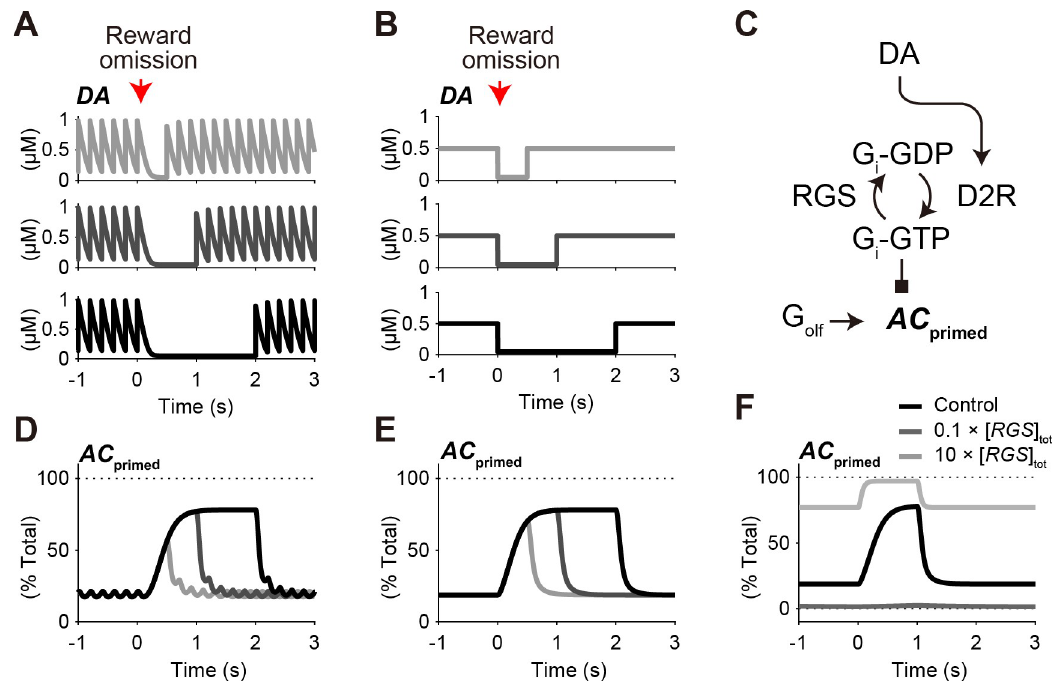
Fig 2. Characterization of optogenetically-evoked DA dynamics as a square wave dip. (A) Simulation of optogenetically-evoked DA dynamics (5 Hz) and their pauses for 0.5 s, 1.0 s, and 2.0 s (top, middle, and bottom, respectively). The tonic optogenetic stimulation is set to generate 0.5 μ M DA on average, and the DA pause is set to give 0.05 μ M DA at bottom levels (see Methods). (B) Characterization of the optogenetic DA signals as square wave dips. (C) Introduction of AC primed as the G i -free and G olf -bound state of AC. Further Ca 2+ stimulation leads to the activity of AC1. In the case of AC5, AC primed corresponds to a normalized activity of AC. (D) Dynamics of AC primed in response to the optogenetically-evoked DA signals. (E) Dynamics of AC primed in response to the square-wave DA dips. (F) Appropriate range of [ RGS ] tot is required for the response of AC primed . Square-wave DA dips are given with a duration of 1 s. AC primed reaches almost the maximal level even with the basal DA signal if [ RGS ] tot is set to be 10 times higher than the standard concentration (9 μ M, light gray line), and AC primed does not show any increase if [ RGS ] tot is 10 times lower than the standard concentration (0.09 μ M, dark gray line).